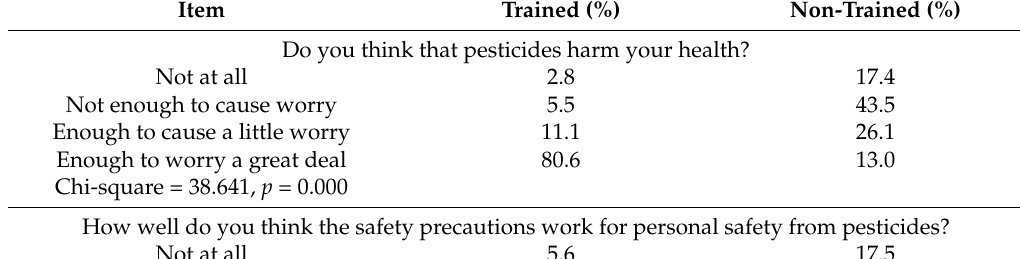
Table 3. Beliefs about pesticide hazard control between trained and non-trained farmers.